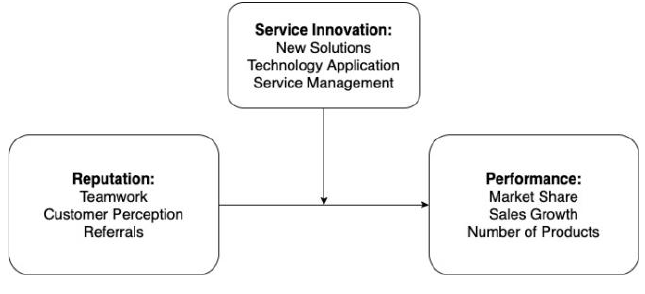
Figure 1: Hypothesized